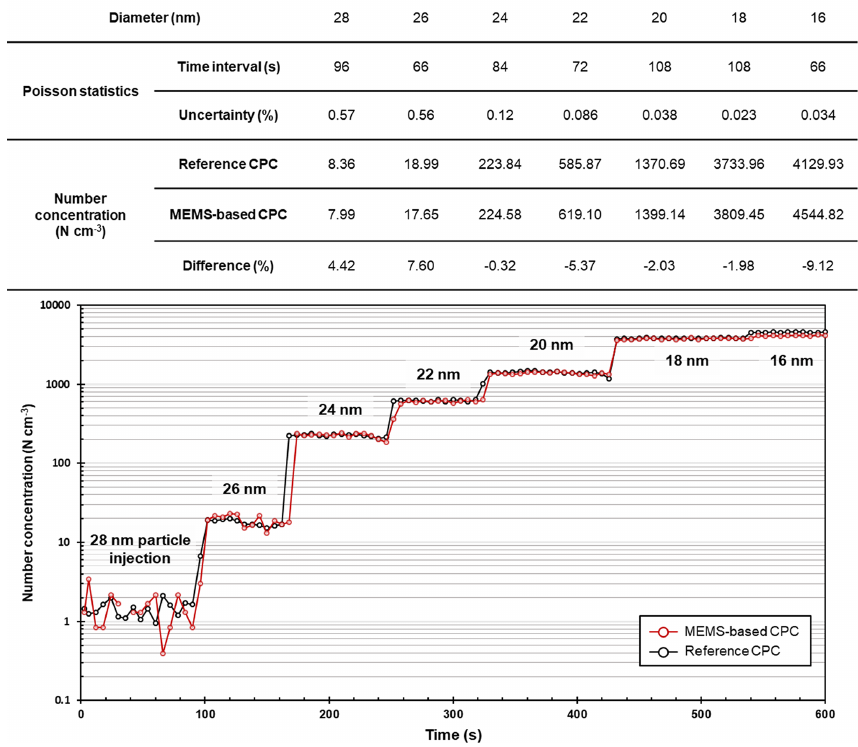
Figure 9. Time series of the number concentrations measured with our system and the reference CPC when the concentration and size were varied.